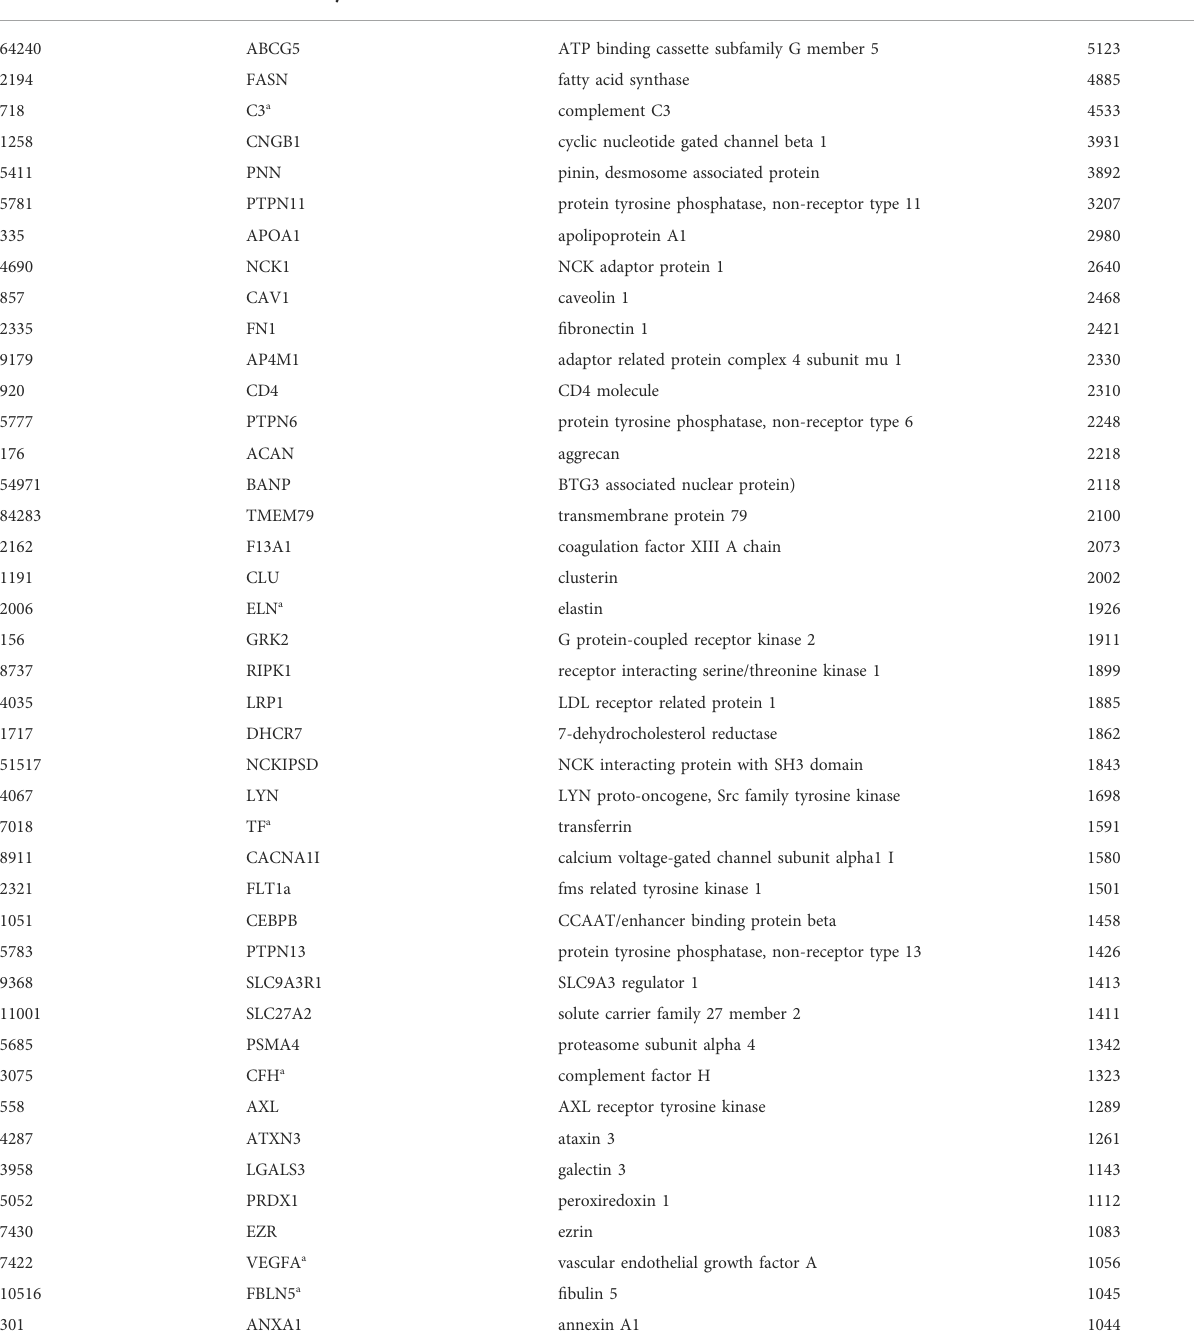
TABLE 5 Shortest path genes with betweenness greater than